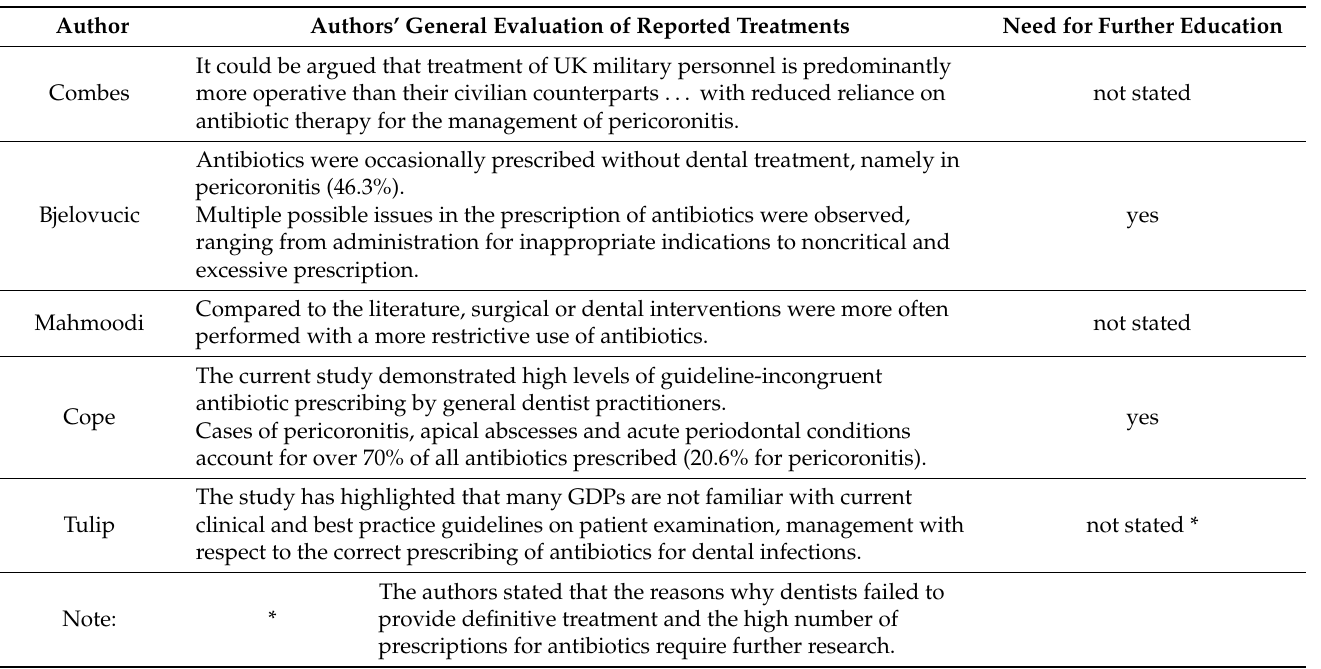
Table 13. Authors’ general evaluation of treatments reported in their studies and authors’ opinion on the need for further education in appropriate